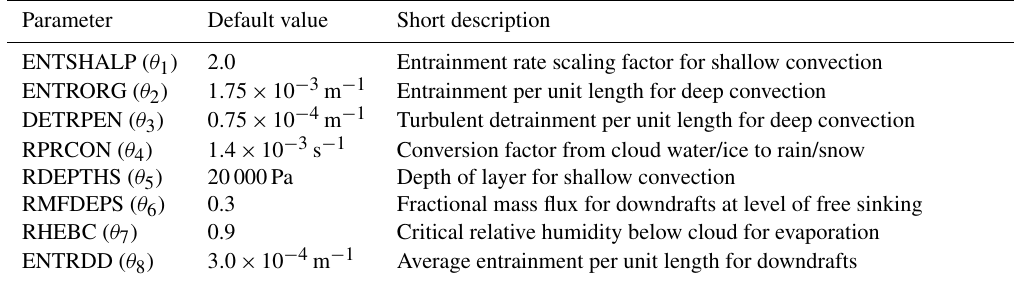
Table 1. Parameters of the convection scheme of OpenIFS. θ 1 and θ 2 are used the most in this study.